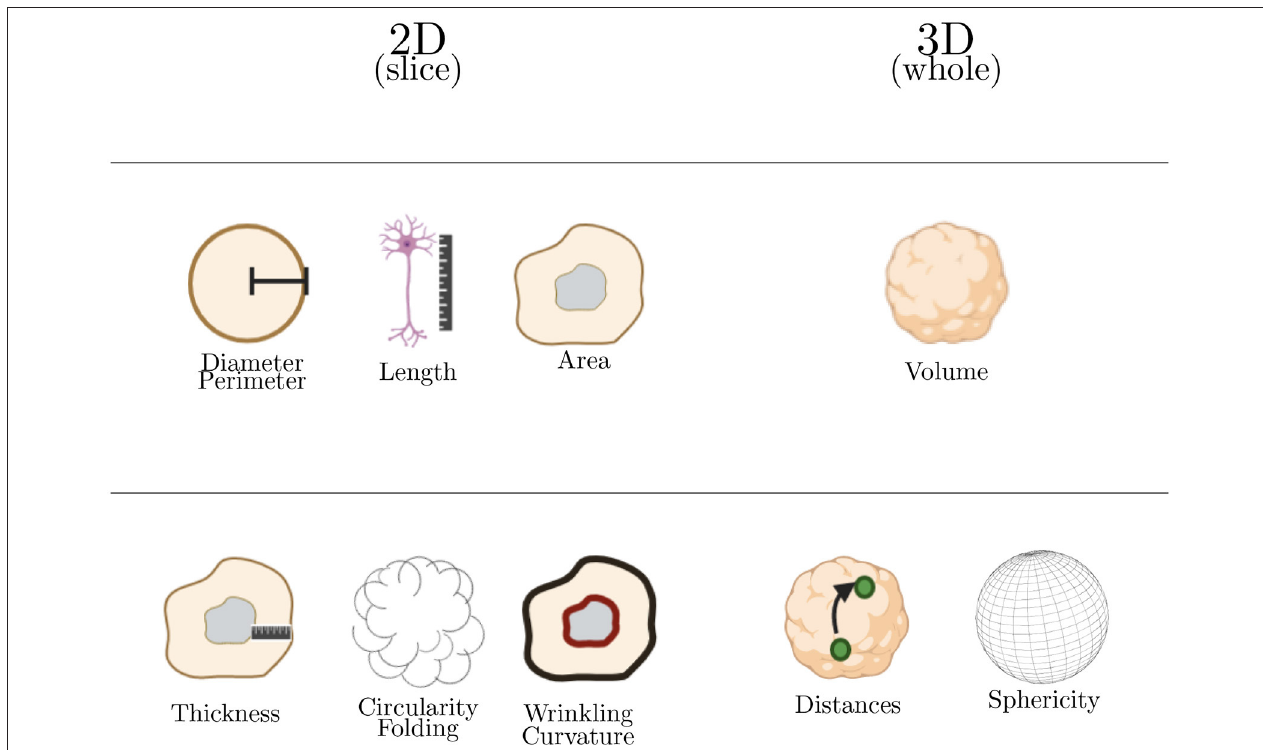
FIGURE 6 | Summary of major morphological analysis performed on cerebral organoids. The first line in this table corresponds to basic morphological analysis and the second one to advanced morphological analysis. Basic parameters are used to calculate the advanced ones.